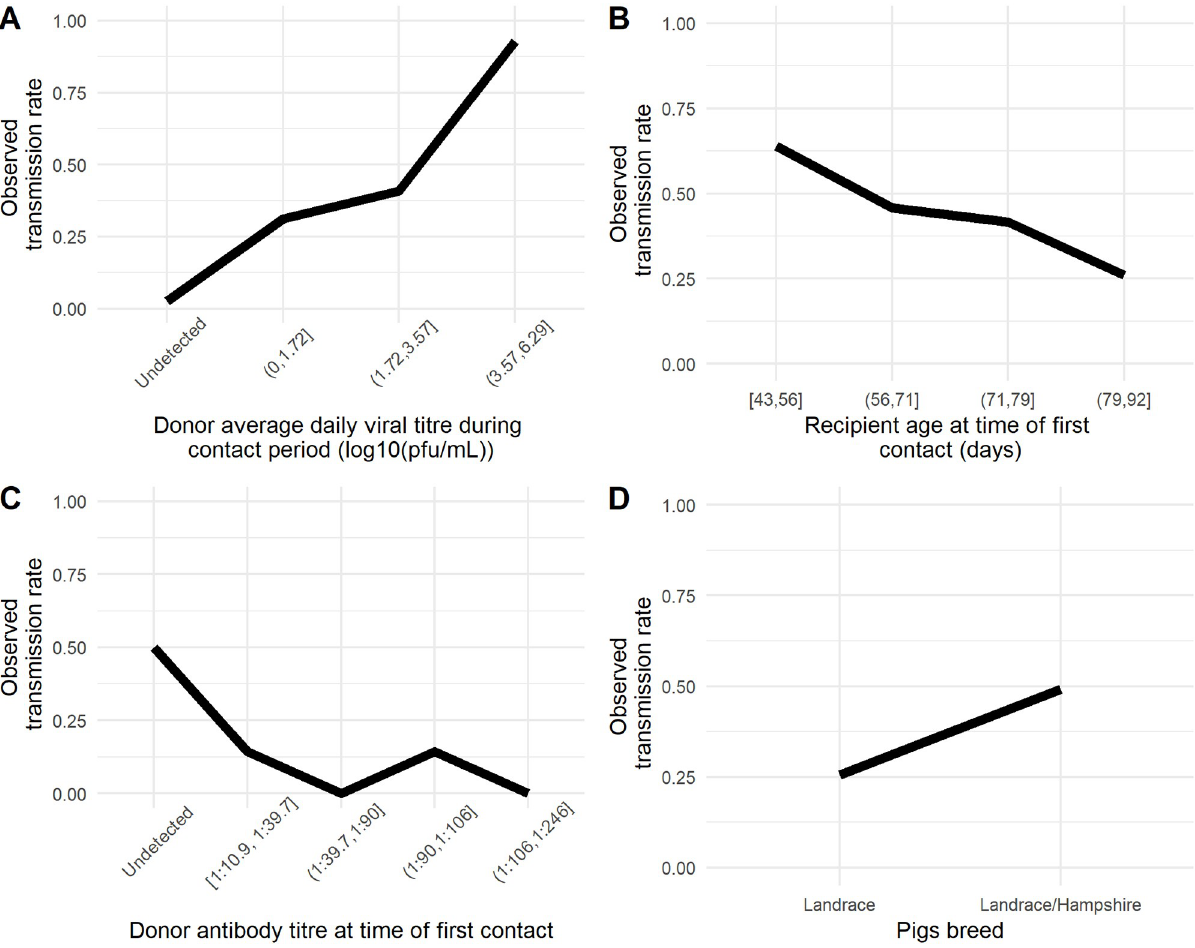
Fig 5. Probability of transmission according to each estimated effect. A. standardized shed virus titre, B. standardized antibody titre, C. Standardized R pigs’ age at time of first contact, D. Pigs’ breed. Donors antibody titre at time of first contact binned as undetected and quartiles for detectable levels; D. Pig breed. The dots represents empirical observations, the black line represent the expected values of the posterior predictive distribution and the grey area represent the 95% uncertainty interval. The values of non-varying predictors were set as the estimated mean.